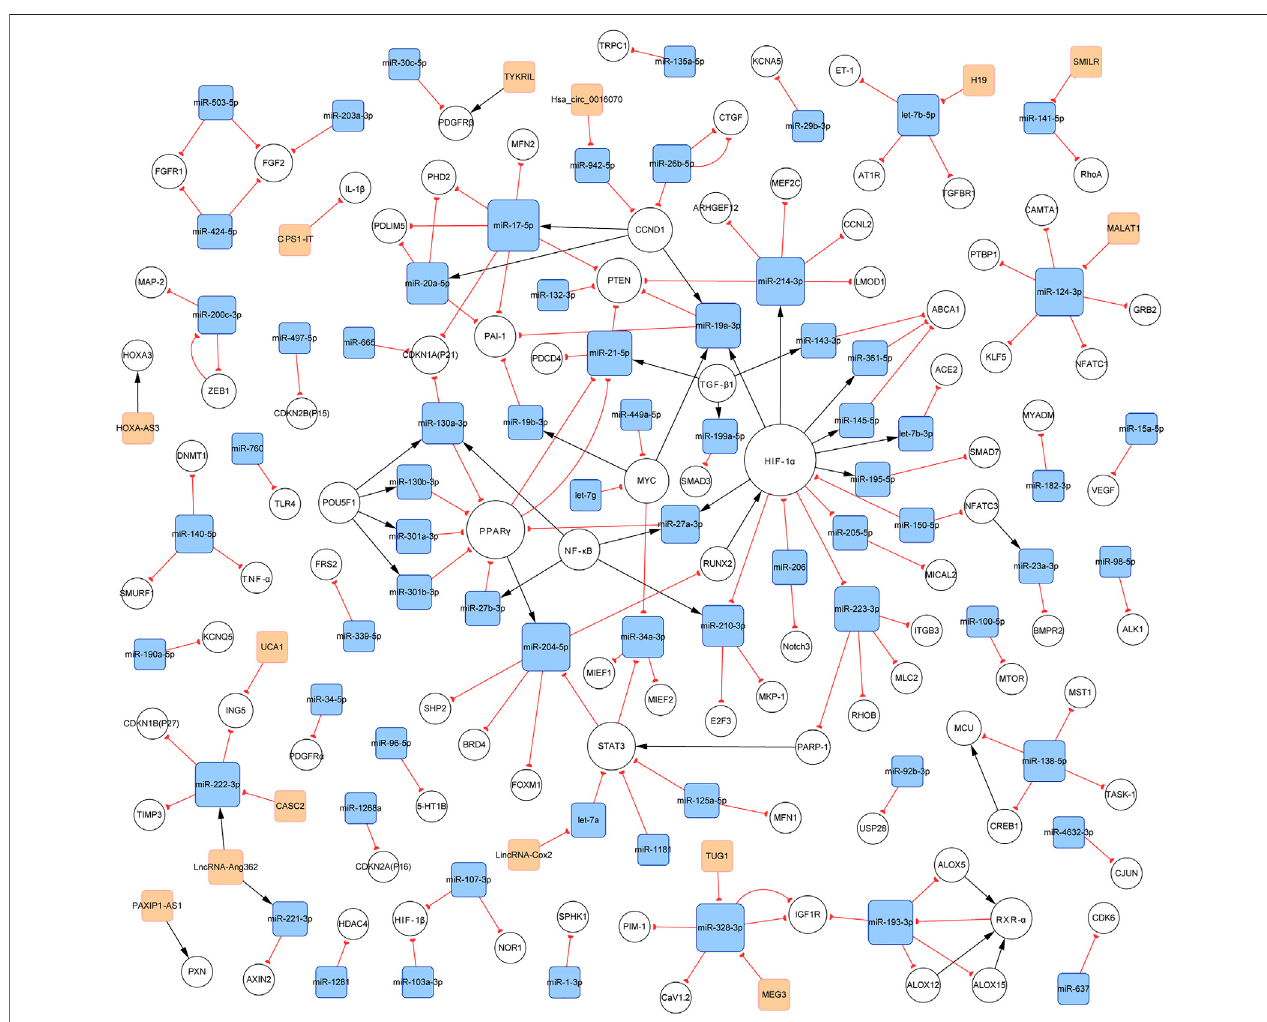
FIGURE 3 | PH-associated network of ncRNAs and their interacting RNAs or genes in PASMCs. The square and circular nodes represent ncRNAs and coding RNAsor genes, respectively.Node colorisbased onthe type of molecule (lncRNAs and circRNAs are orange, miRNAsare blue, and codingRNAsor genesare empty). Nodesizesrepresentthedegrees(thenumberofedgesthatdirectlylinktothenode).Edgesrepresenttheregulatoryconnections,andeachedgeindicatesapublication. Whenmultiplepublications describeoneinteraction, multipleedgesconnectthesametwonodes. Rededgesdepictlinksindicatingrepressiveaction (semicircular arrow heads), and black edges are those indicating activation (with traditional arrow heads). The nodes in this network are involved in cell proliferation, apoptosis, migration, and metabolism. PH: pulmonary hypertension; PASMCs: pulmonary artery smooth muscle cells; lncRNAs: long non-coding RNAs; circRNA: circular RNA; miRNA: